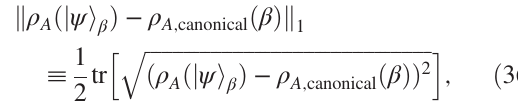
FIG. 5. Scaling of the entropy deviation Δ S α ≡ β ÞÞ − S ρ ψ i 1 =L , for constant L S α ð ρ , α ð β ÞÞ with A; canonical ð A ðj A averaged over all eigenstates in the range 0 . 28 < β < 0 . 32 , for S 1 (top panel) and S 2 (bottom panel). The error bars represent one standard deviation away from the mean. For S 1 , this deviation is strictly non-negative, but, for higher Renyi entropies, it can oscillate and become negative before tending to zero as L → ∞ .